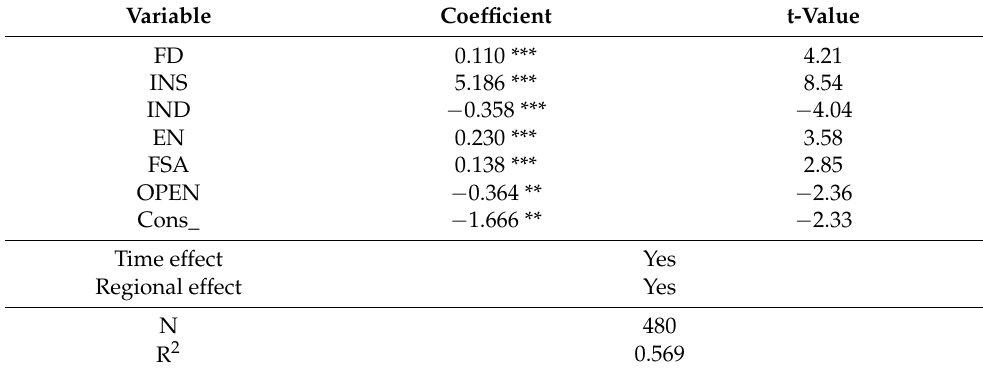
Table 4. Estimation results of FD on